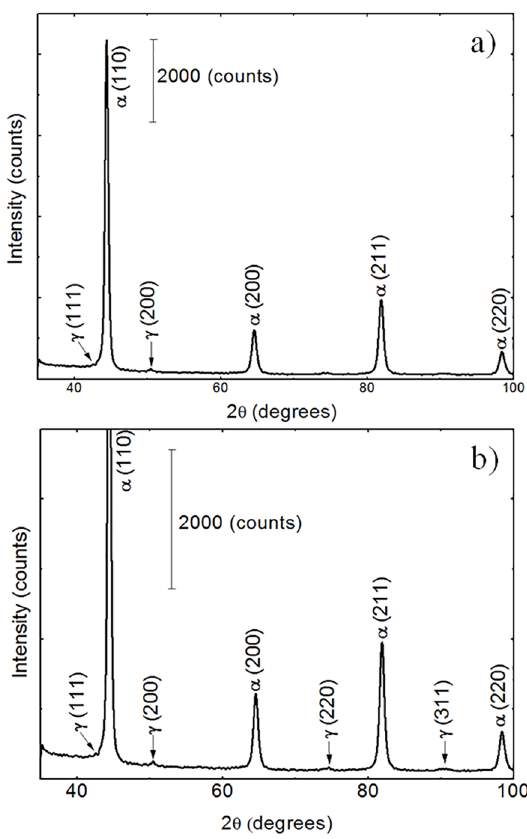
Figure 4. (a) X-Ray diffraction of the supermartensitic steel tempering at a temperature range of 600-640°C and (b) Magnification of diffractogram to show low intensity